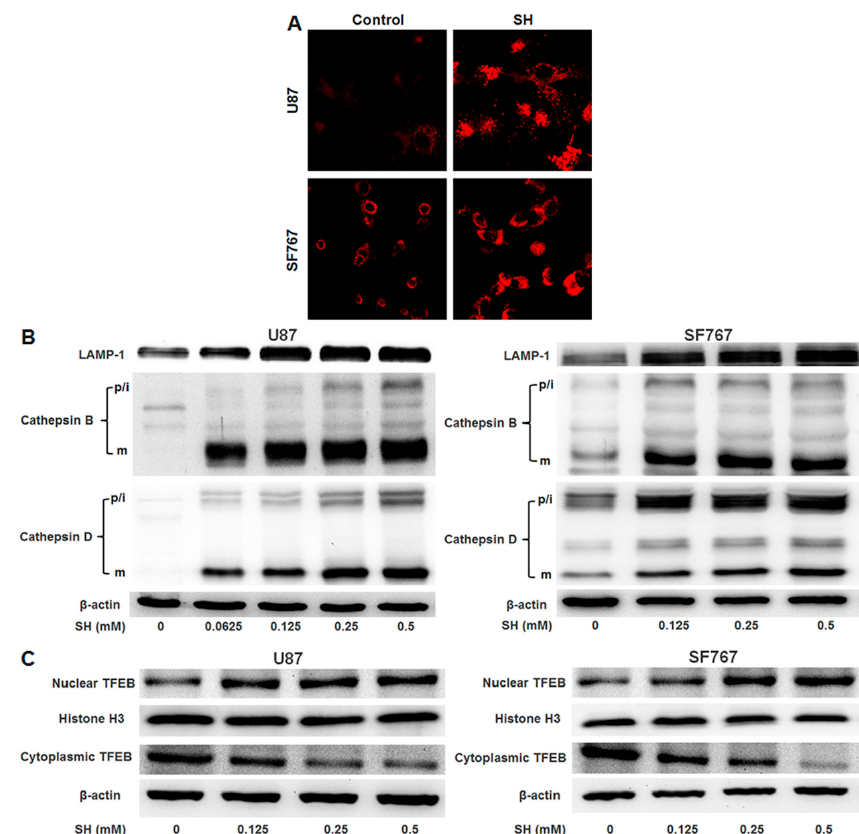
Figure 6. SH facilitates lysosomal biogenesis in U87 and SF767 cells. ( A ) After 24 h of SH (0.5 mM) treatment, the cells were stained with LTR and imaged via confocal microscopy; ( B ) U87 and SF767 cells were treated with the indicated concentrations of SH for 24 h. The expression levels of lysosome markers (LAMP1, cathepsin B, cathepsin D) were observed via Western blotting analysis. p/i, precursor/intermediate; m, mature form of cathepsin B and cathepsin D; ( C ) Effects of SH on the nuclear translocation of TFEB. U87 and SF767 cells were treated with the indicated concentrations of SH for 24 h. The expression levels of TFEB in the cytosolic and nuclear fractions were detected through Western blotting analysis. Histone H3 and β -actin were used as loading controls for the nuclear and cytoplasmic fractions, respectively. Each image is representative of n = 3 experiments. All blots shown are representative of n = 3 experiments, with similar results.